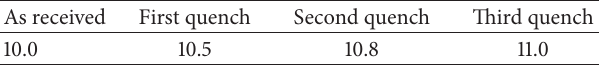
Table 1: ASTM grain size number for the tested specimens.